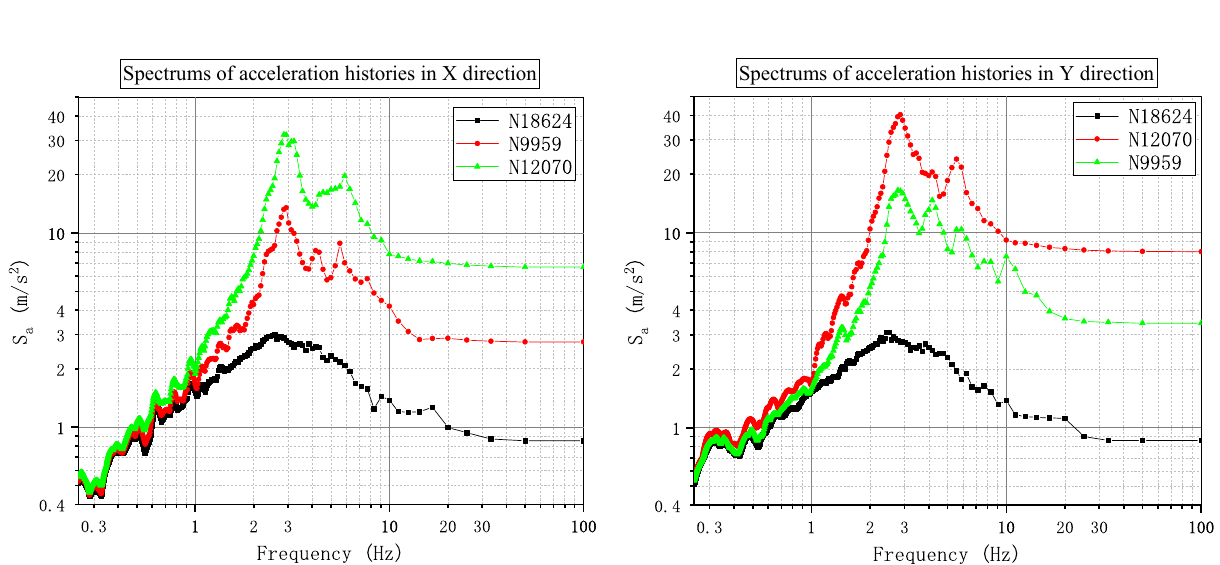
Spectrums of acceleration histories in X direction